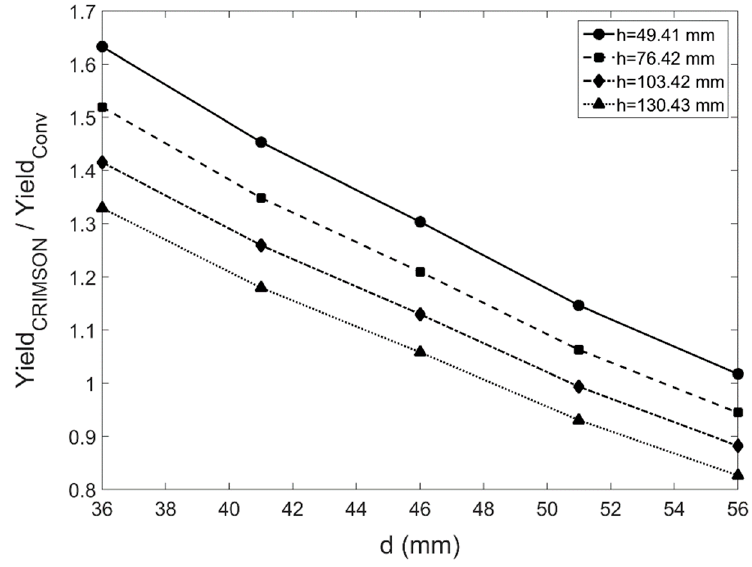
Figure 5. Normalised yield plotted as a function of the riser dimensions.